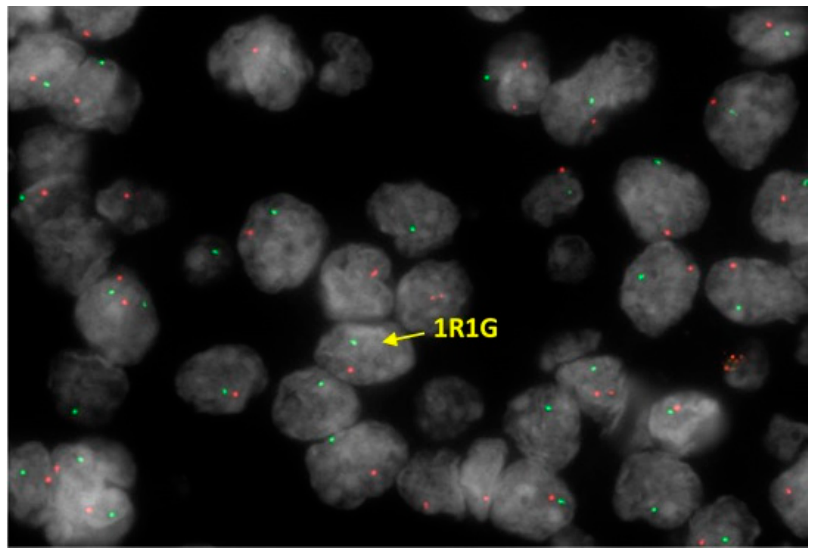
Figure 5. Fluorescence in situ hybridization (FISH) performed on LG-ESS, which shows JAZF1 rearrangement using dual colour break apart probe. Additionally, the other copy of JAZF1 is lost. Results are expressed as split R (separate red signal) and G (separate green signal) rearrangement.